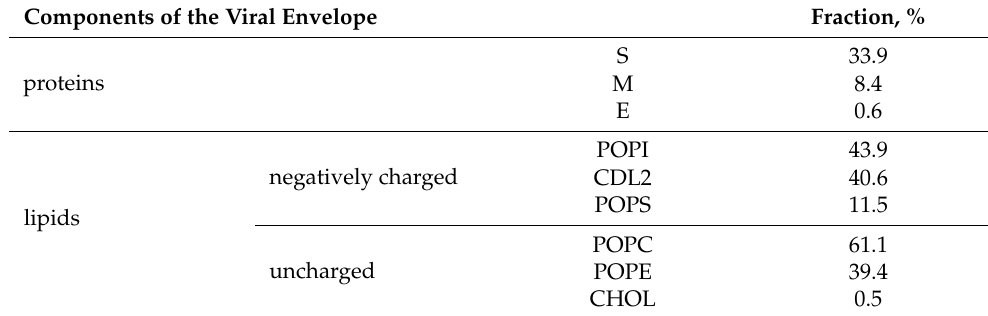
Table 1. Statistics of contacts of ZnPcChol 8+ molecule with different components of the viral envelope. Components of the Viral Envelope